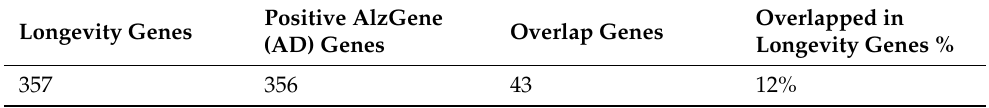
Table 6. Comparison of Longevity and AD Genes.